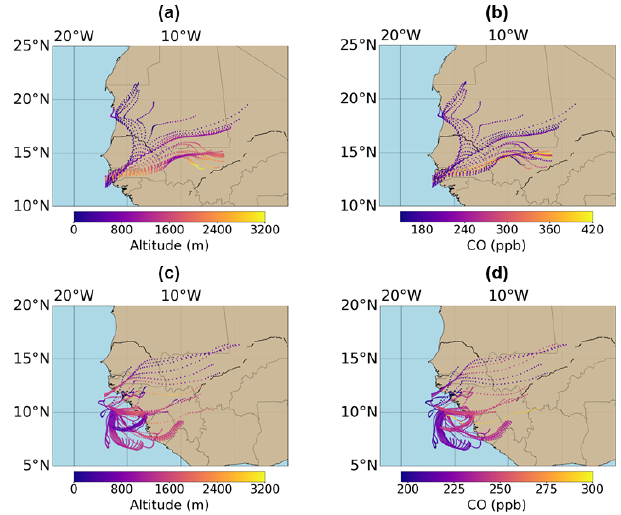
Figure 9. The 2d HYSPLIT back trajectories from sections of the flight tracks of flights C006 and C007 during which biomass burn- ing emissions were sampled (the in-fire-plume data from Fig. 10). The back trajectories are coloured by (a) trajectory altitude and (b) CO mixing ratio at the trajectory end point on the flight C006 flight track. Panels (c) and (d) show the back trajectories for flight C007, coloured by trajectory altitude and CO mixing ratio respectively. Trajectories are run at 60s intervals of in-plume flight data. The base maps are obtained from Global Self-consistent, Hierarchical, High-resolution Geography Database (GSHHG) data (Wessel and Smith.